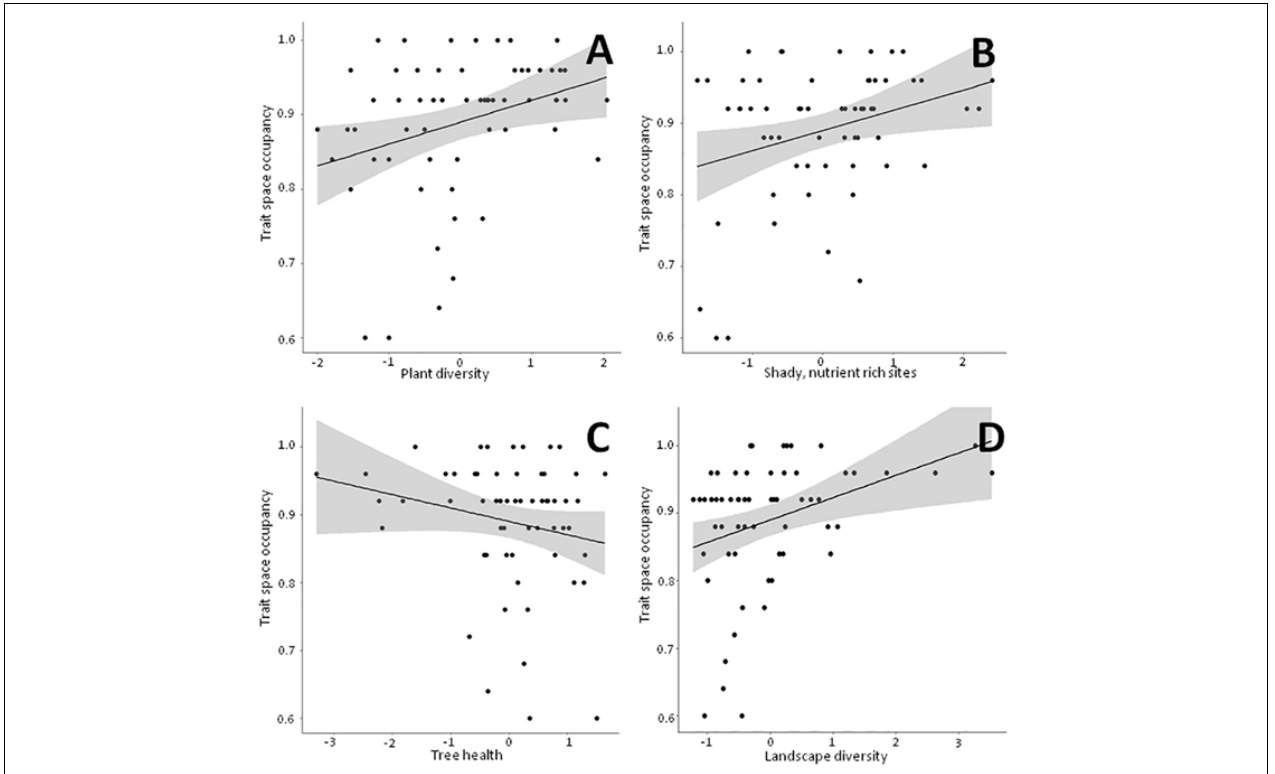
FIGURE 4 | Linear bivariate regressions showing the relationships between trait space occupancy and the PC axes depicting (A) Plant diversity, (B) Shady, humid, nutrient rich sites, (C) Tree health and (D) Landscape diversity. The detailed results of the linear mixed effects models (shown as black line and shaded area) can be looked up in Supplementary Table 4